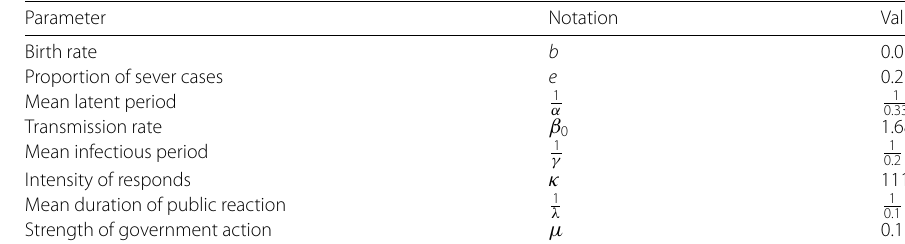
Figure 1 ( a ) Bifurcation diagram when β 0 is the main bifurcation parameter: ( a ) Enlargement of ( a ). (solid) Stable branch; (dash) unstable branch; (filled circle) stable periodic branch; (square) Hopf